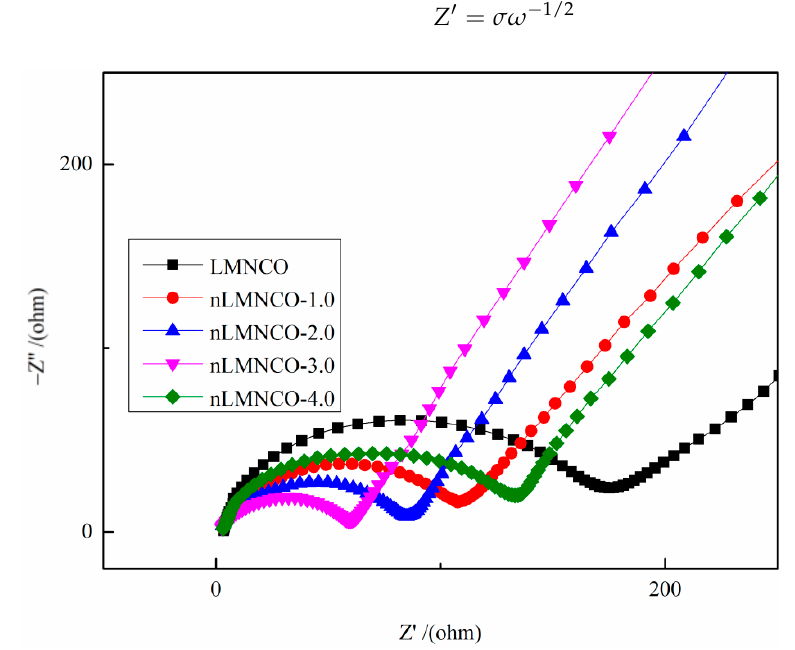
Figure 13. Nyquist spectra of the cathode materials.